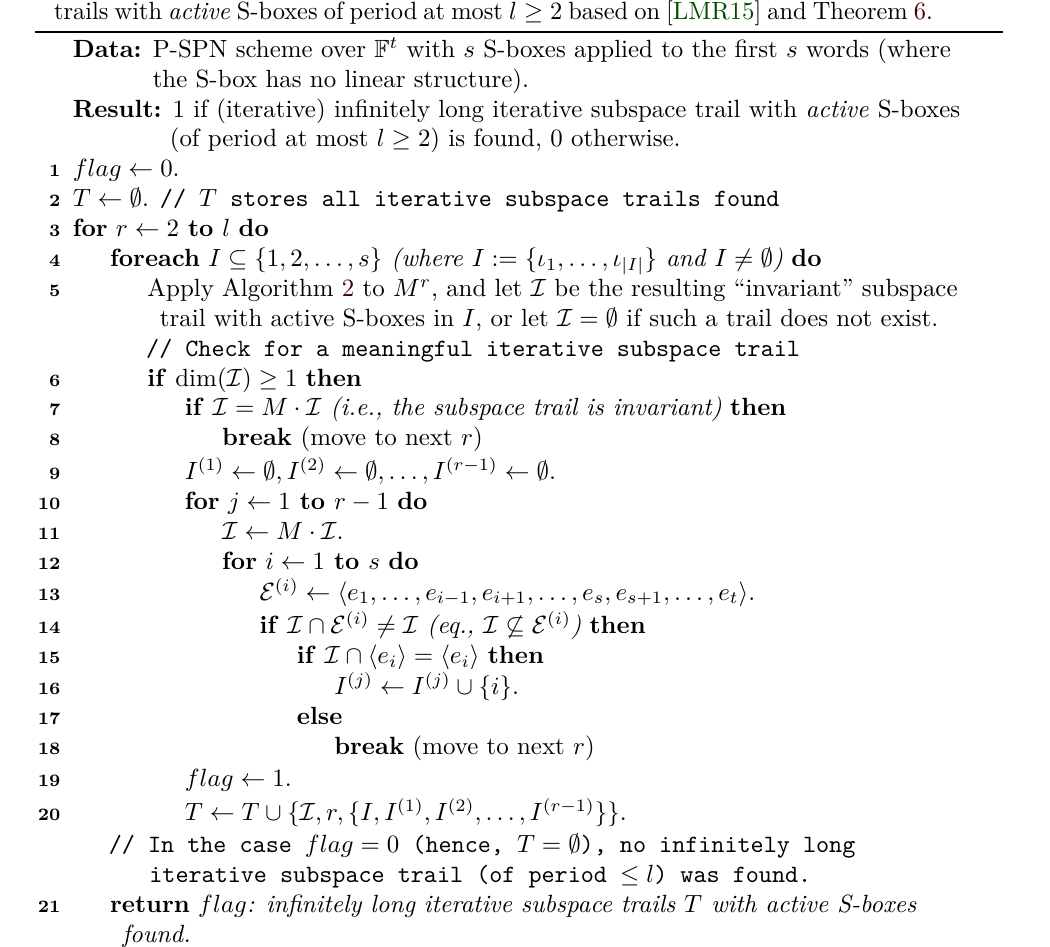
Algorithm 3: Determining the existence of (iterative) infinitely long subspace trails with active S-boxes of period at most l ≥ 2 based on [LMR15] and Theorem 6. Data: P-SPN scheme over F t with s S-boxes applied to the first s words (where the S-box has no linear